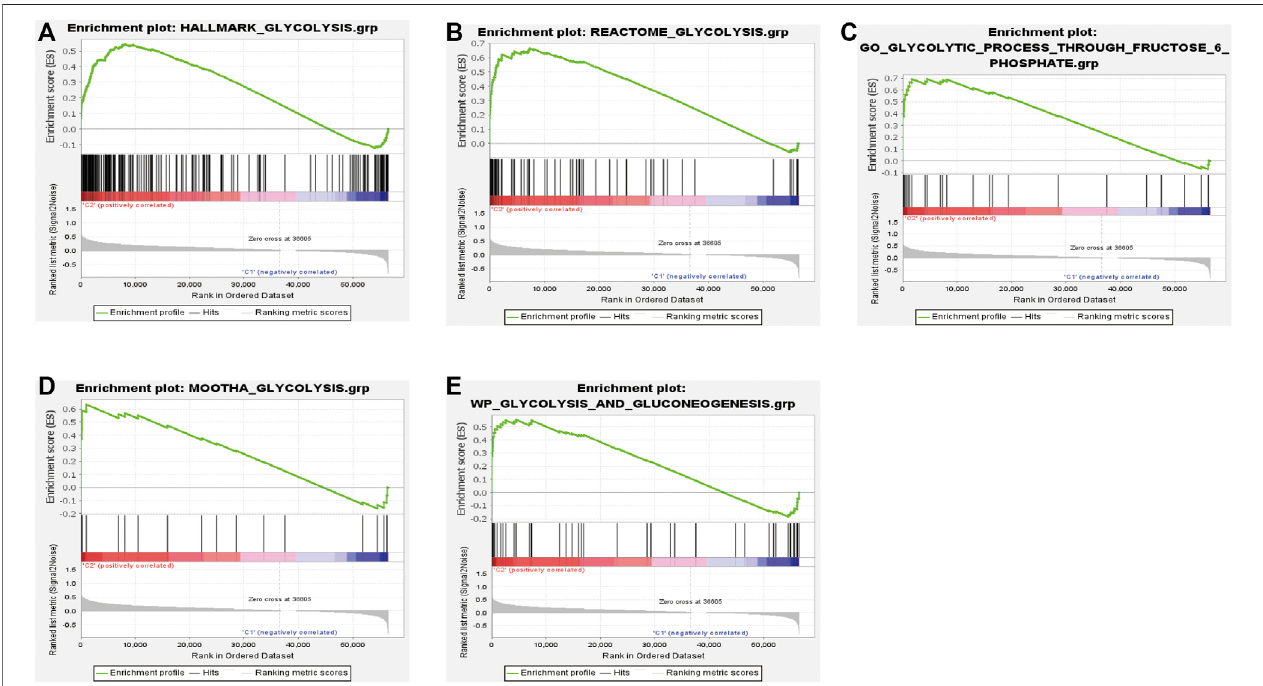
FIGURE 4 | Signi fi cantly enriched glycolysis signaling pathways in cluster 2 based on GSEA (A-E) .